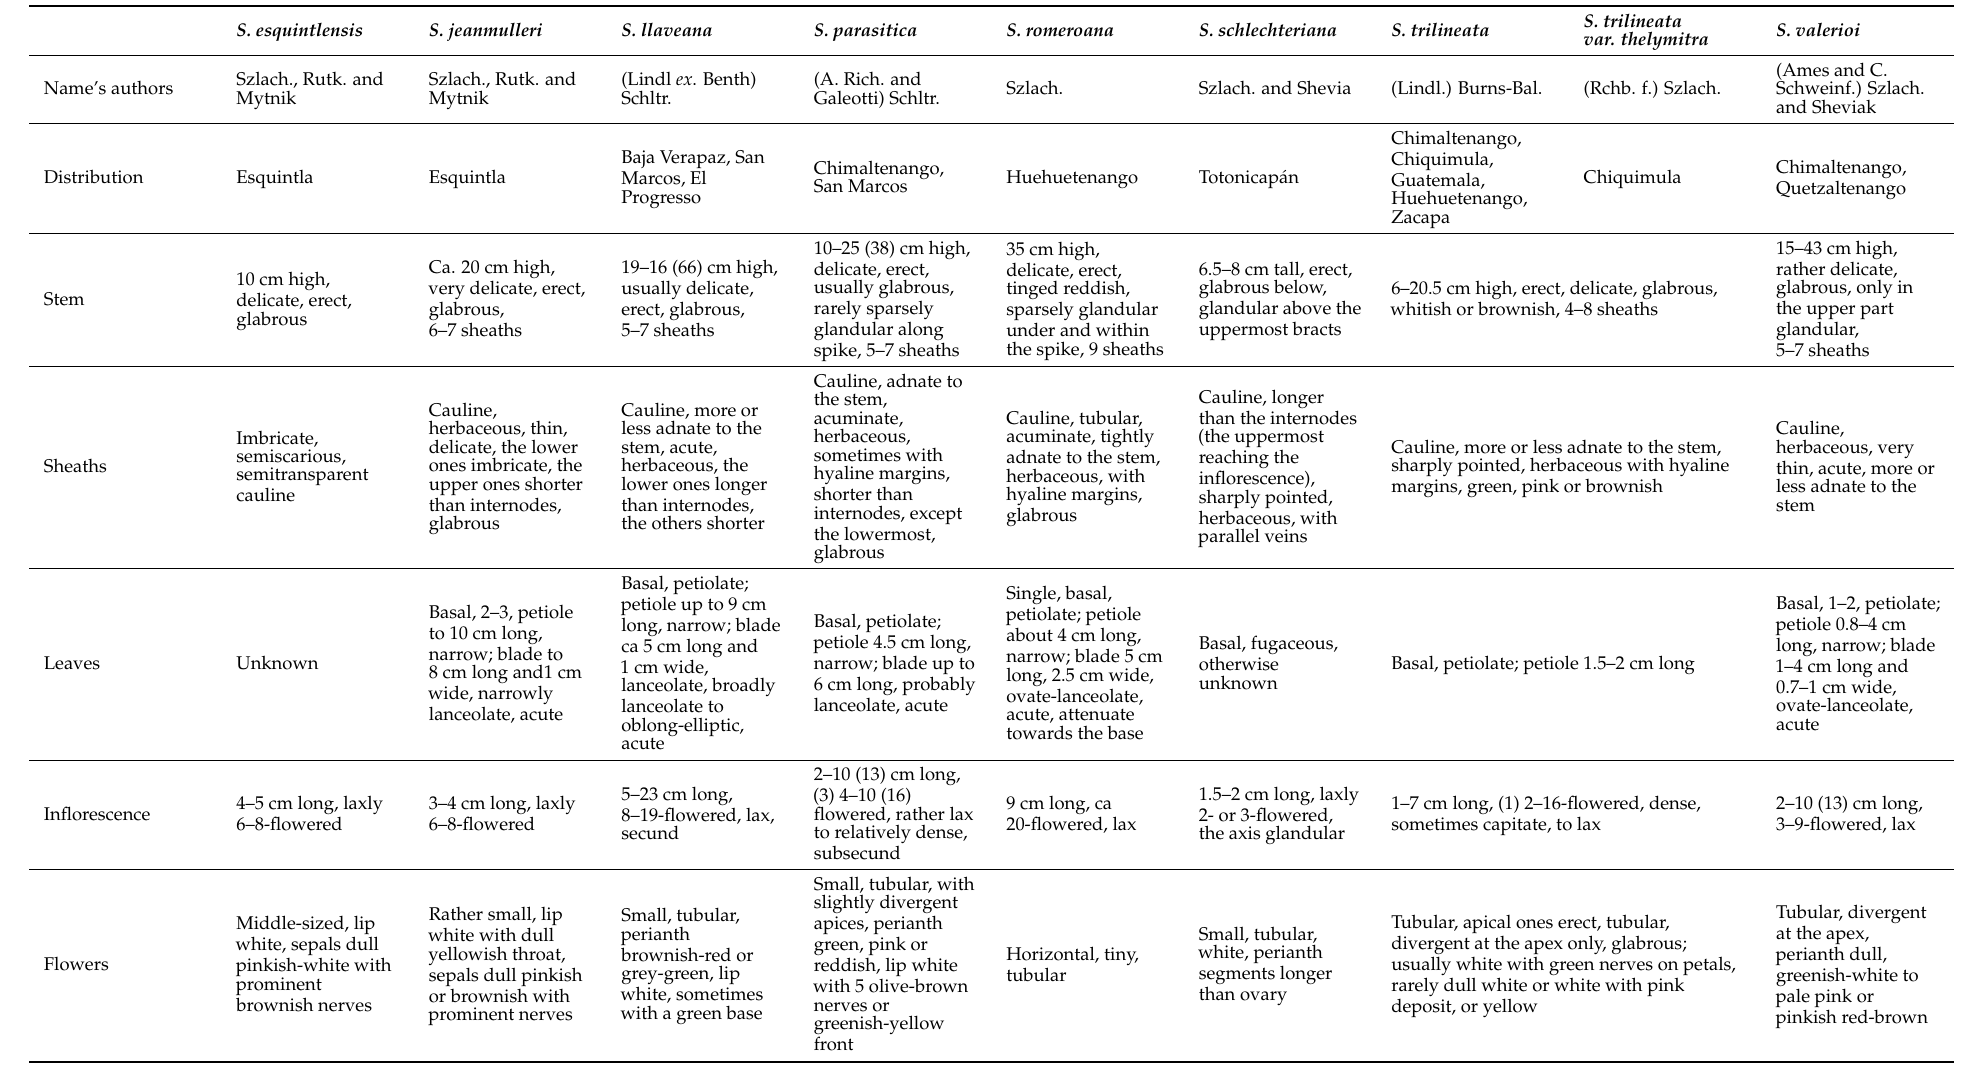
Table 1. Comparison between the morphological features of Guatemalan representatives of the genus Schiedeella